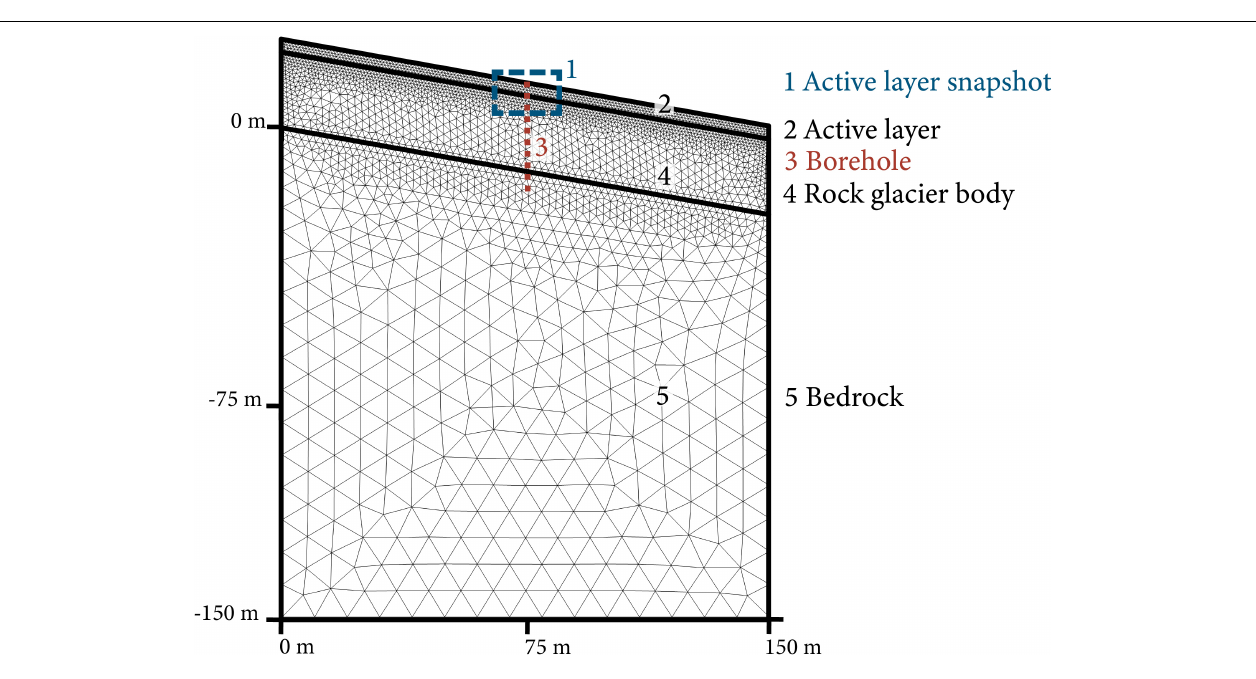
borehole data are taken in the middle of the